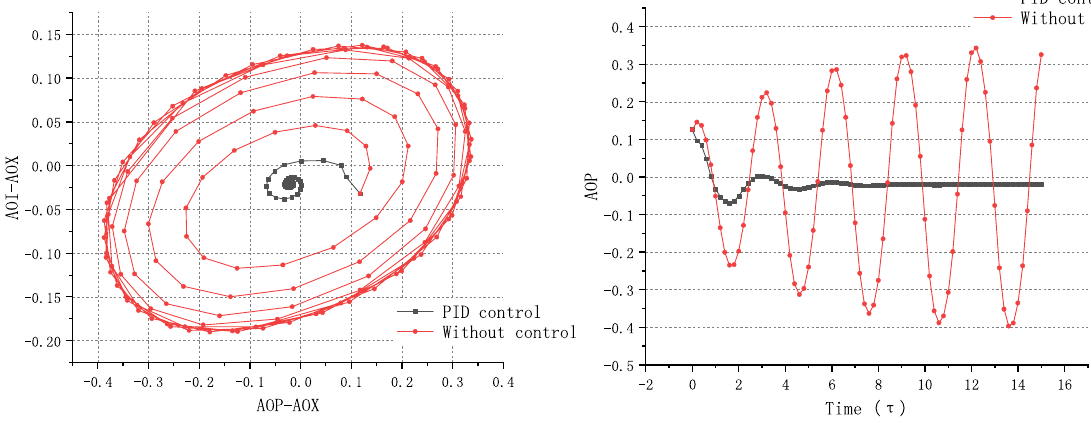
Fig. 10. Effect of our PID control strategy (38) with K p = − 75, T i = 50, T d = 0.01.